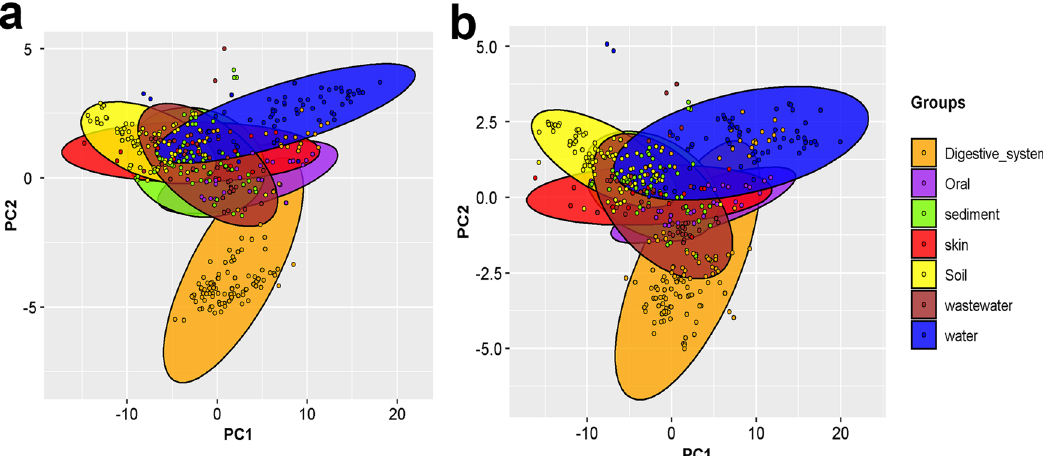
Fig. 3 Principal component analysis (PCA) on the codon usage frequency of samples from seven environmental biomes. PCA analysis was applied on the codon usage frequencies of samples from seven selected biomes. For each sample, codon frequencies were calculated by two methods absCUFs and synCUFs (see main text). In panel a PCA was done based on absCUFs and in panel b PCA was done based on synCUFs. Each point in the fi gure represents one sample. Samples are colored according to the environmental feature from where those were collected. The color scheme is shown in the legend. The fi rst two components (PC1 and PC2) of the PCA are presented here. The fi rst two components (PC1 and PC2) explain more than 70% of the variance in codon frequencies in the